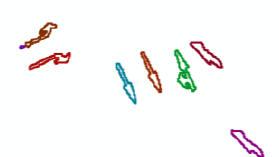
Figure 10. Sample resulting polyline shapefiles.